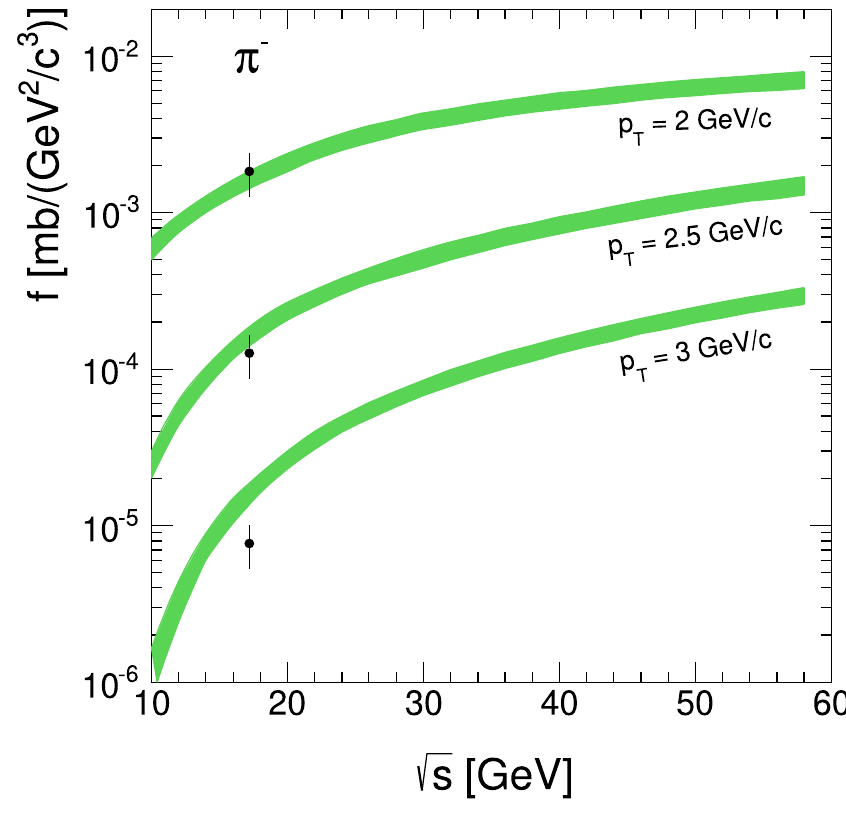
Fig. 198 Invariant π − cross sections at x F = 0.0 as a √ s indicated as function of bands with a width of ± 15% at p T = 2.0, 2.5 and 3.0 GeV/c. The predicted yields from resonance decay are given as √ s = 17.2 GeV at the points at same p T values with estimated errors of